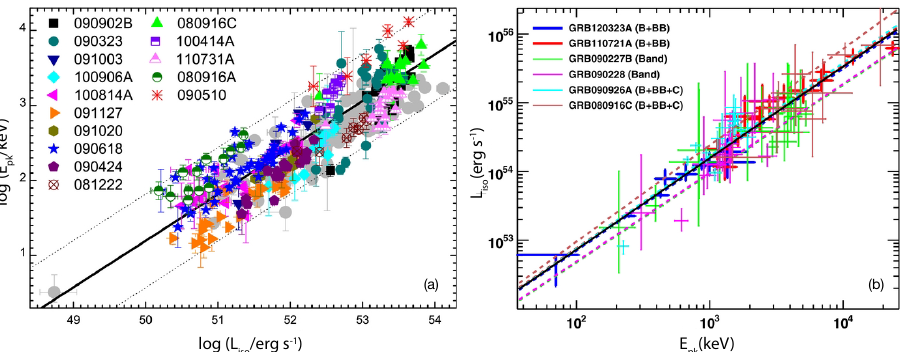
Figure 6. The Golenetskii relations taken from Lu et al. [179] ( a ) and Guiriec et al. [39] ( b ). In panel ( a ), the best fit given by Equation (19) is shown as the solid black line, and its 2 σ dispersion is shown as the dotted lines. The 15 GRBs used to obtain the relation are shown as various marker types and colors. The gray circle markers are the GRBs from the sample used by Yonetoku et al. [112] in the location that they would appear on the Yonetoku relation, thus showing that the dispersion in the Yonetoku relation is similar to the dispersion in the Golenetskii relation. Panel ( b ) shows the bet fit Golenetskii relation given in Equation (20) as the solid black line. The different color points with errorbars show the location of various GRBs that were used to determine the best fit Golenetskii relation. The fits to individual GRBs are shown as dashed lines with identical colors. The multispectral components that are used to fit each burst’s spectra are denoted in the legend, where “B” or “band” denotes band, “C” denotes a cutoff power-law, and “BB” denotes a blackbody spectrum. ©AAS. Reproduced with